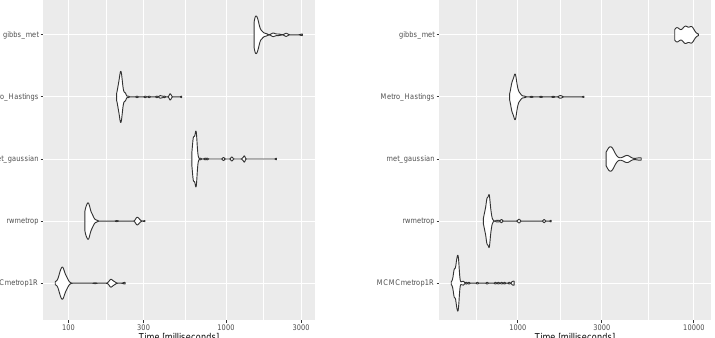
Figure 14. Execution times for generating a sample size of n = 100 from a transformed sine model ( left ) and a transformed cosine model ( right ) for each